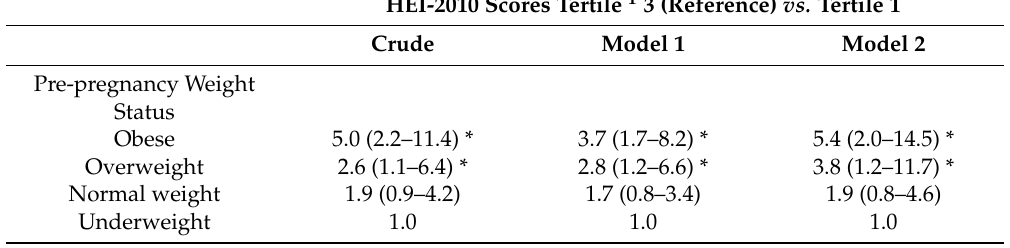
Table 5. Associations between the lowest Healthy Eating Index (HEI)-2010 tertile and pre-pregnancy weight status